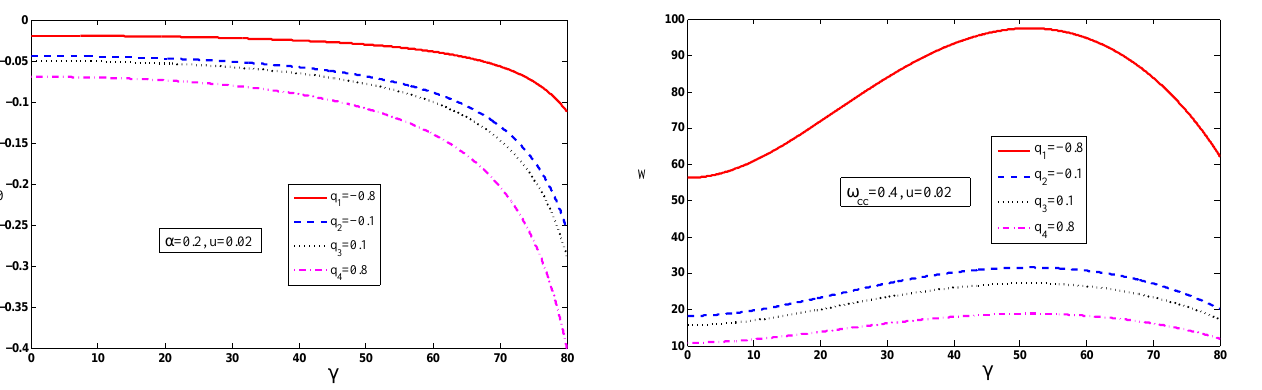
Fig. 4. Soliton width as functions of γ with different values for the parameter q .